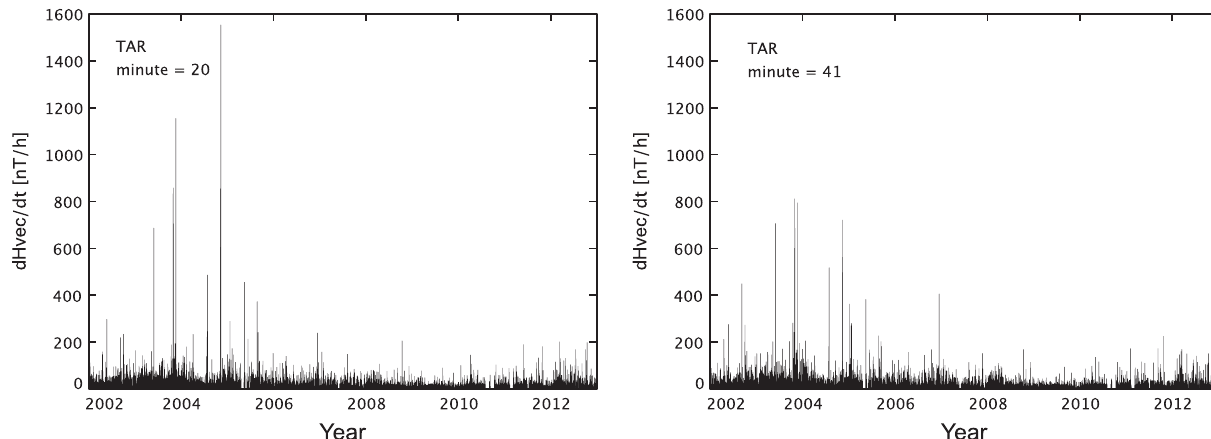
Fig. 9. All values of |d H /d t | at TAR in 2002–2012 for 1-h spot readings at minutes 20 (left) and 41